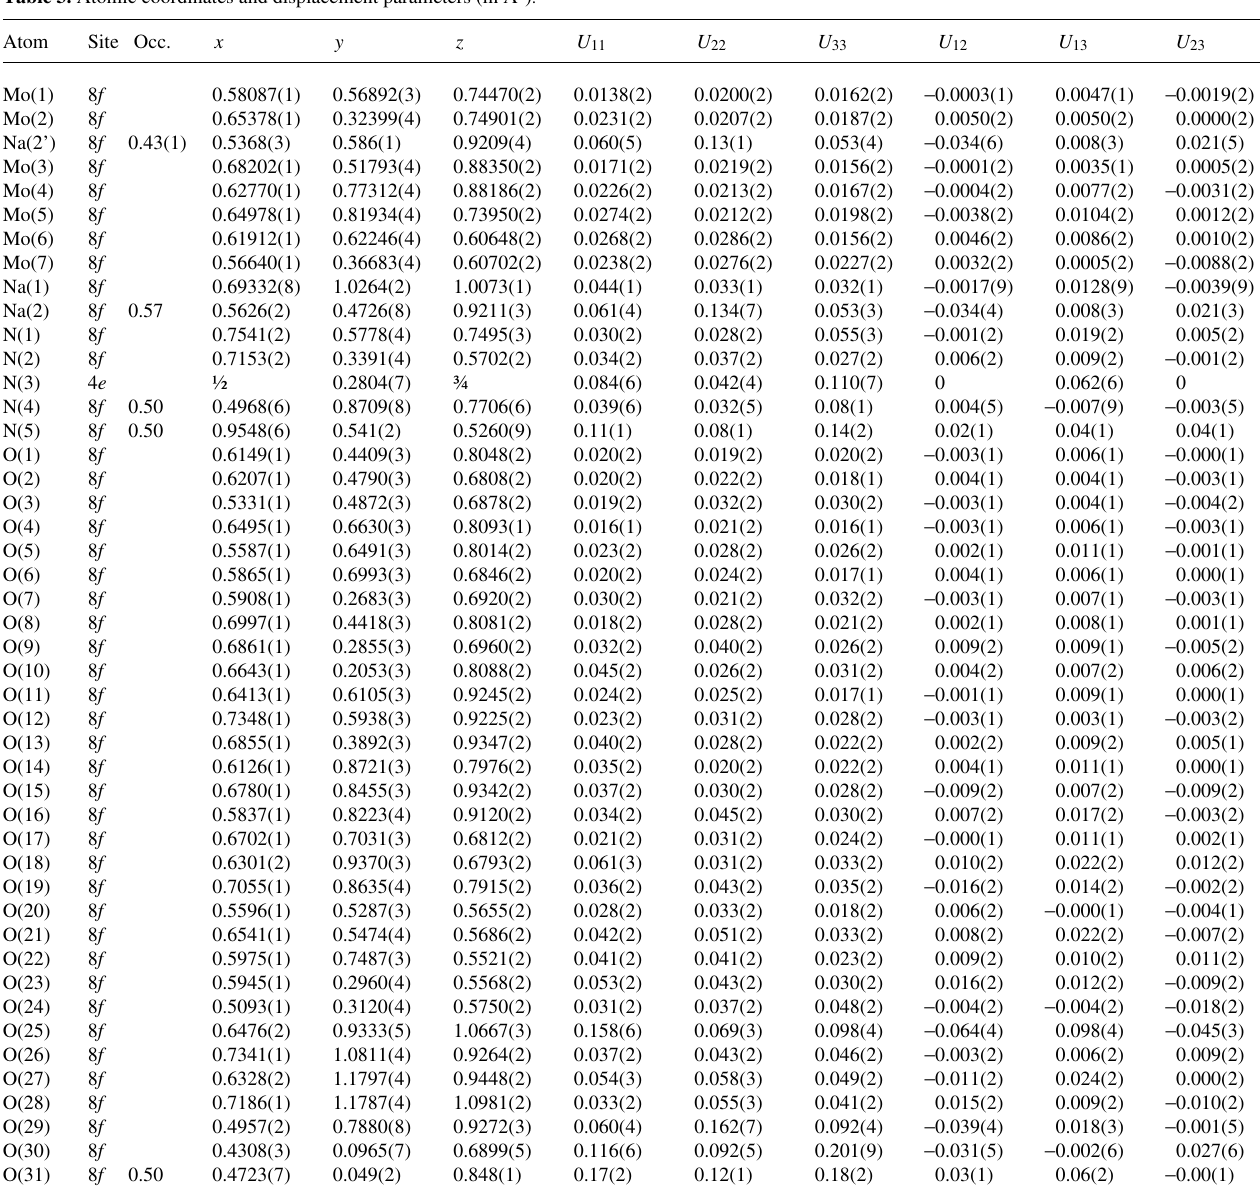
Table 3. Atomic coordinates and displacement parameters (in Å 2 )